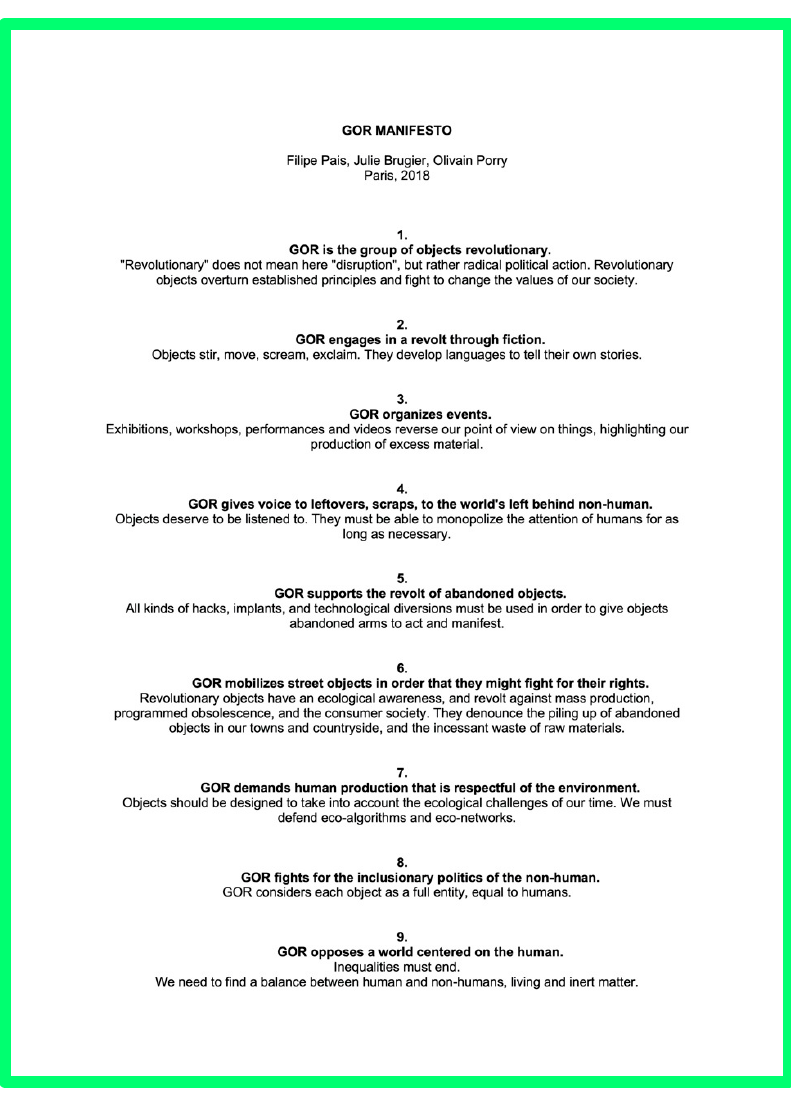
Figure 6. GOR Manifesto, Paris 2018.